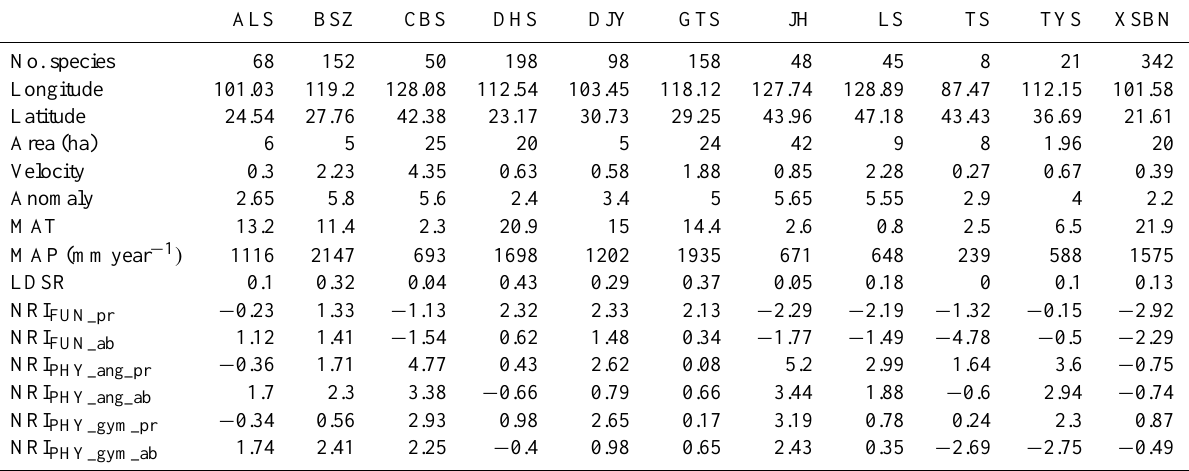
Table A1. General information of 11 forest plots in China. No.species: number of species in each plot. Anomaly: LGM–present MAT anomaly. MAT: mean annual temperature. MAP: mean annual precipitation. LDSR: proportion of light demanding species. NRI FUN : func- tional ( H max ) NRI, and NRI PHY : phylogenetic NRI, both based on either presence–absence ( pr ) or abundances ( ab ) with gymnosperms ( gym ) or only considering angiosperms ( ang ) .